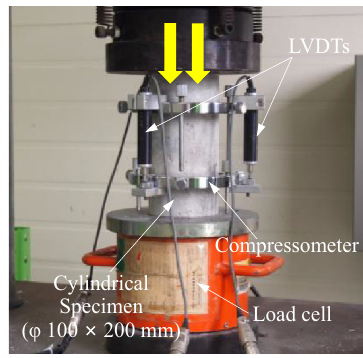
Fig. 2 Compressive test (ASTM C39).